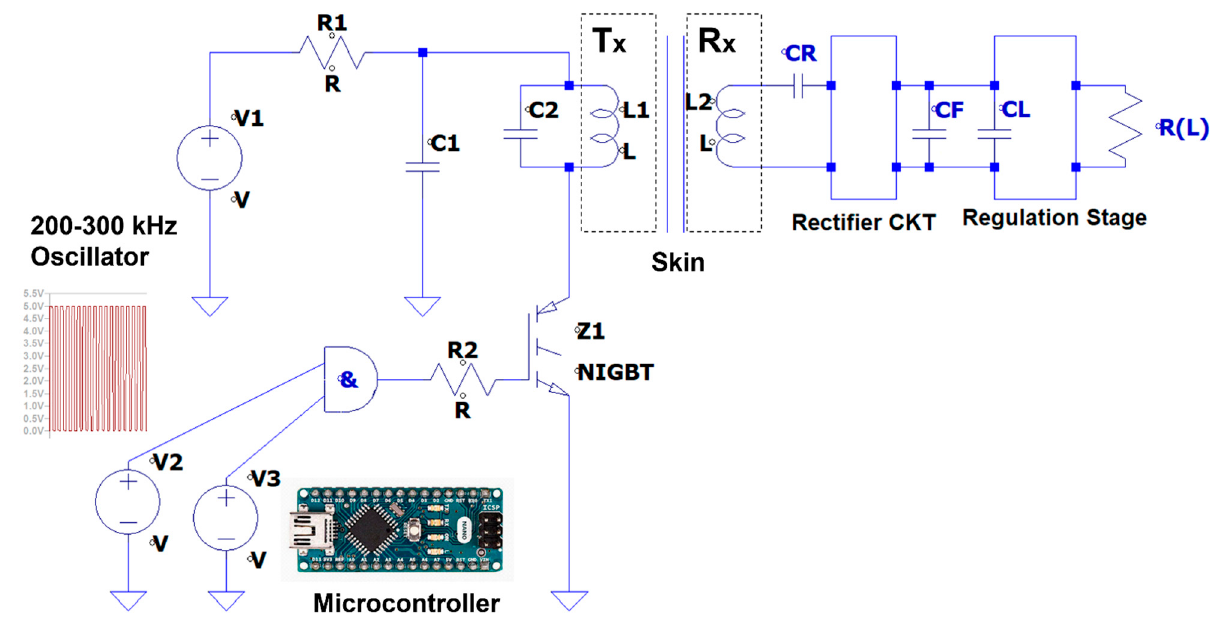
Figure 2. WPT system architecture with external transmitter (Tx) and implanted receiver (Rx) coil and temperature-sense-probe units.